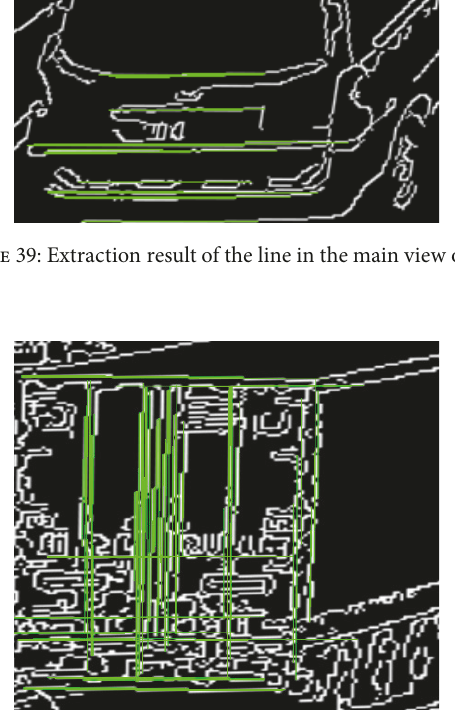
Figure 37: Three-view color image of car.